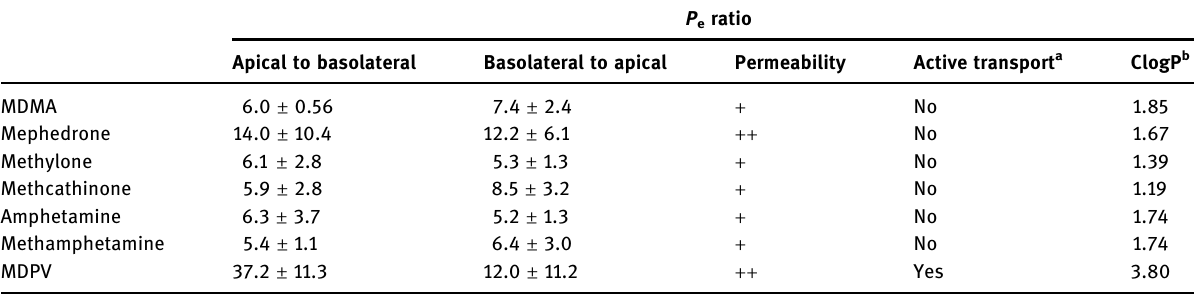
Table 3: Blood – brain barrier permeability for selected psychoactive substances [ 221